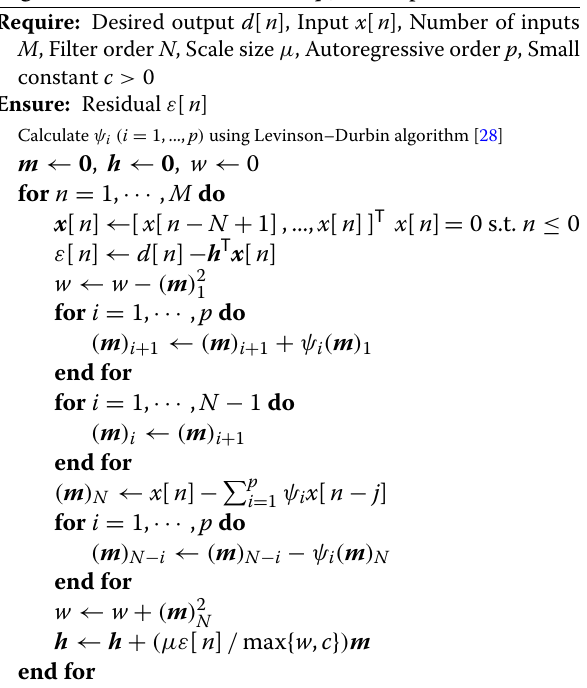
Algorithm 1 NNGSA with AR ( p ) assumption